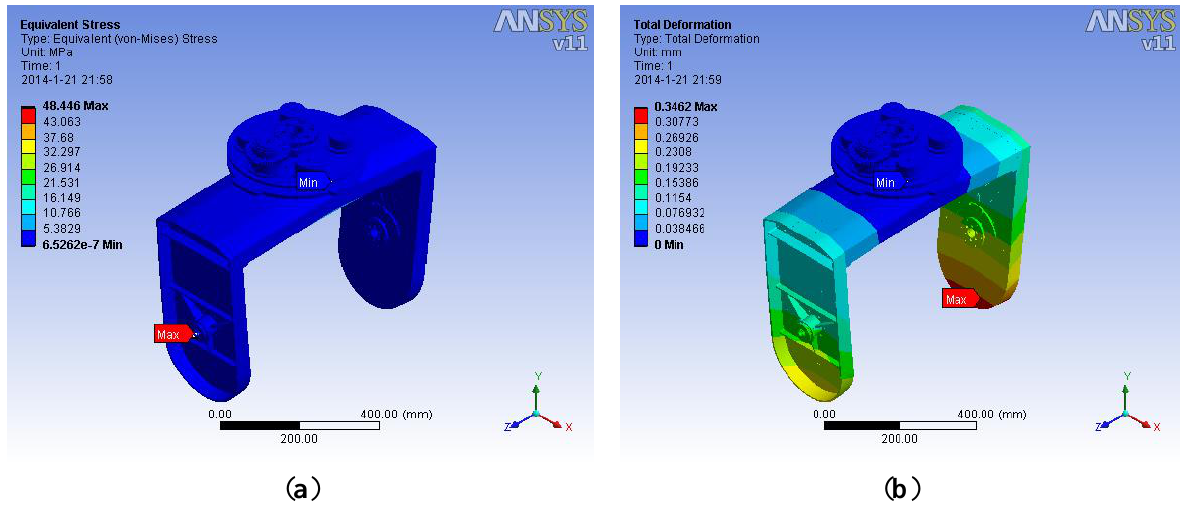
Figure 5. FEA static results: ( a ) Displacement distribution and ( b ) Stress distribution.